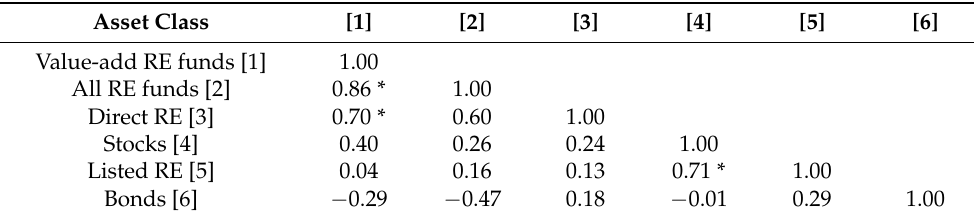
Table 5. Correlation analysis of non-listed Japanese value-add real estate funds: 2010–2020. Asset Class [1] [2] [3] [4] [5] [6] Value-add RE funds [1]